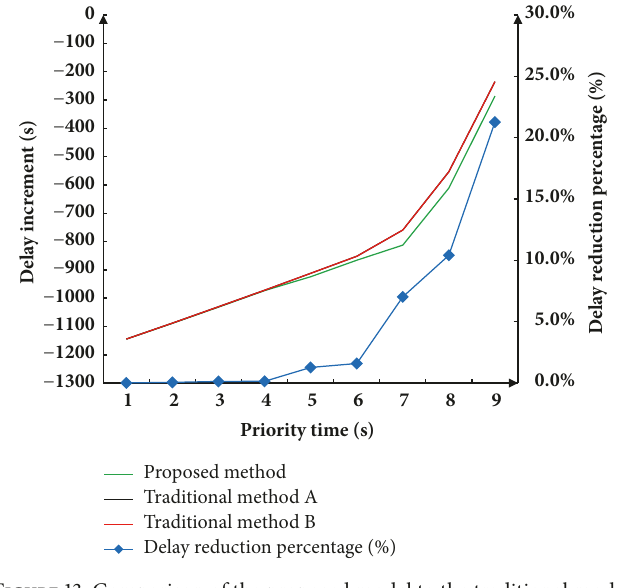
Figure 13: Comparison of the proposed model to the traditional model.